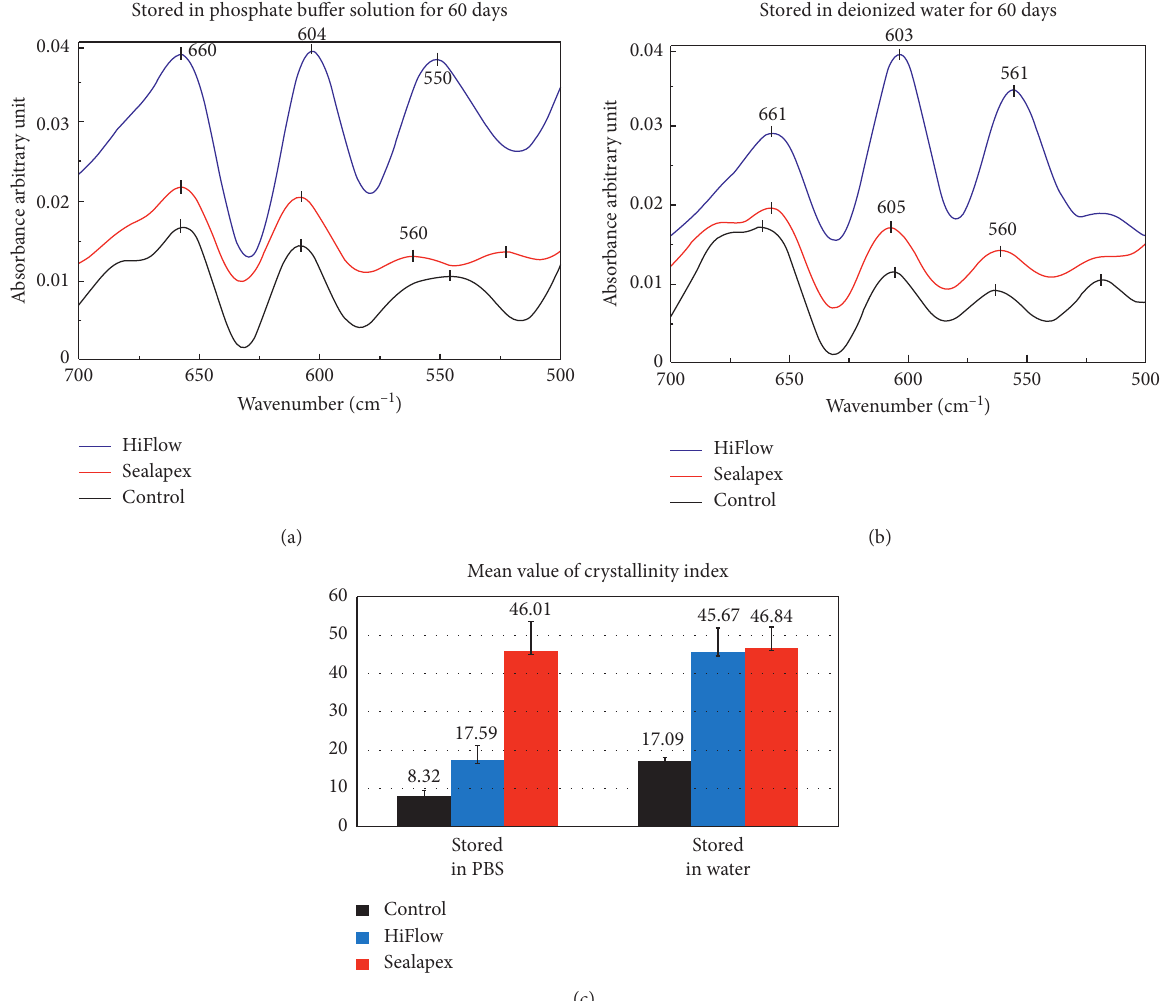
v phosphate, v carbonate 1 3 2